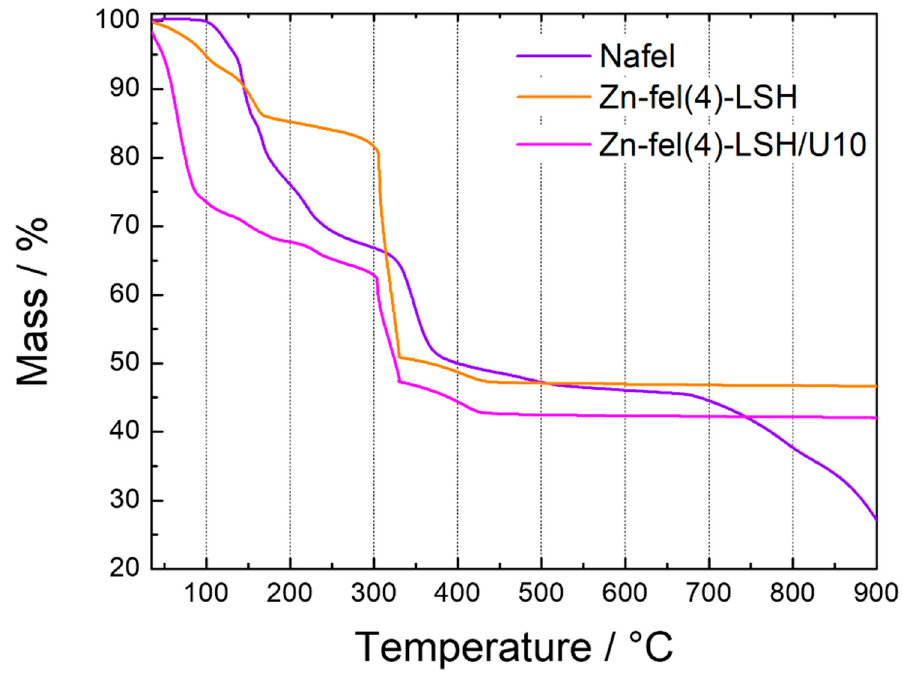
Figure A4. TGA curves of Nafel salt (NaC 10 H 9 O 4 ), Zn-fel(4)-LSH and Zn-fel(4)-LSH/U10 samples.